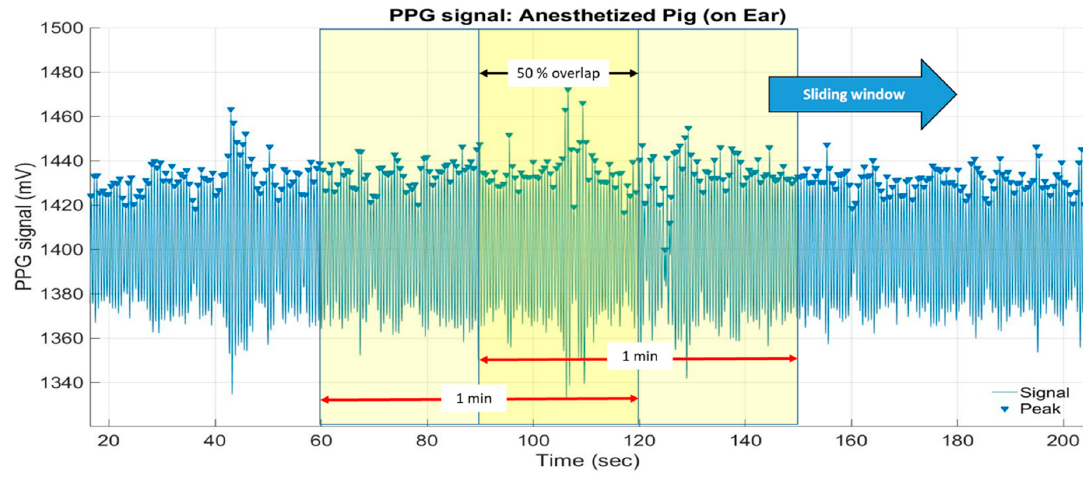
Figure 6. One-minute sliding window with 50% (30 s) overlap to calculate the heart rate (bpm) based on the number of detected peaks per time